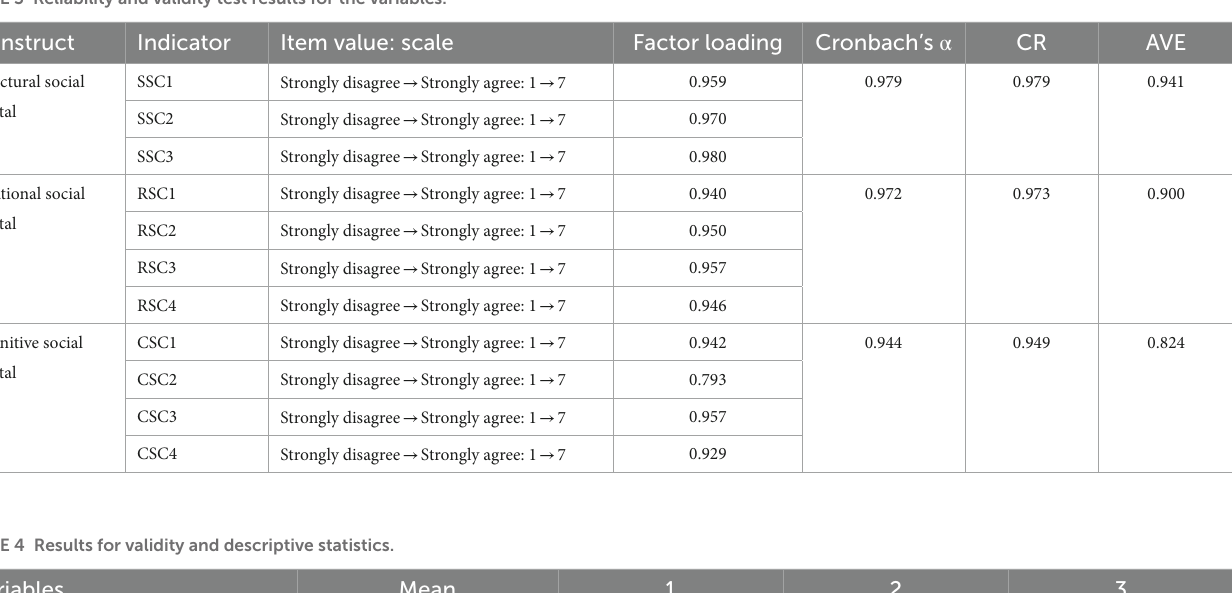
TABLE 3 Reliability and validity test results for the